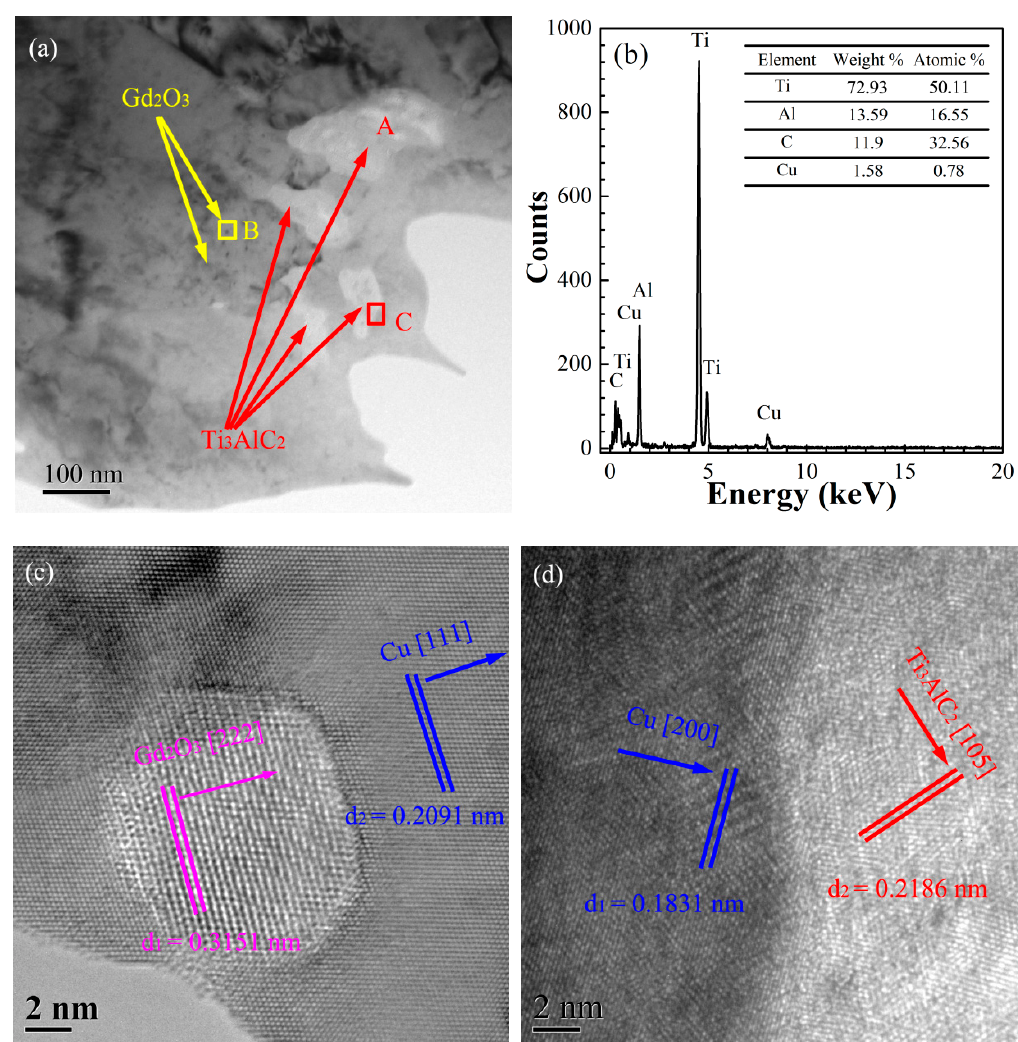
Figure 8. The TEM and EDS images of Cu@Ti 3 AlC 2 -Gd 2 O 3 /Cu composite: ( a ) the bright field image; ( b ) the energy spectra of area A in Figure 8a; ( c ) and ( d ) are the high-resolution images of areas B and C in Figure 8a, respectively.